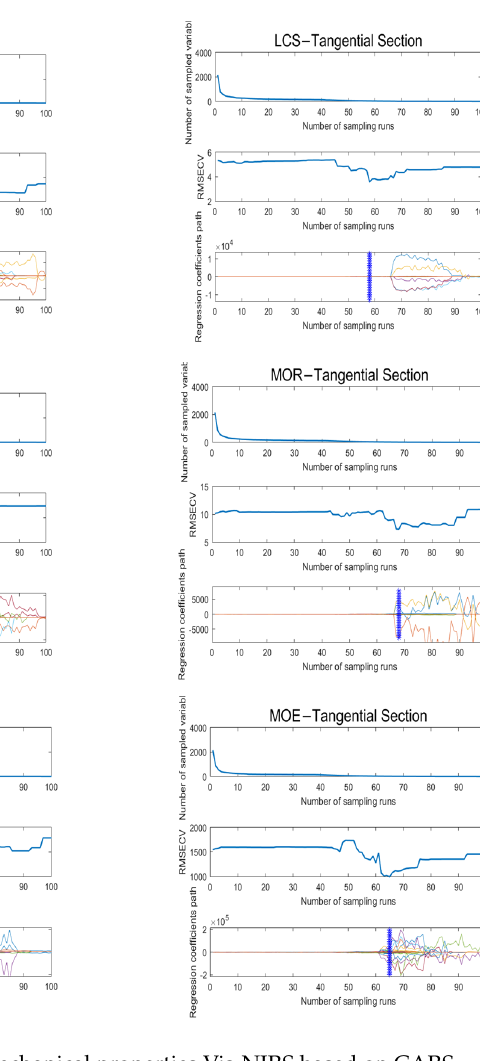
SiPLS was used in combination with UVE, SPA and CARS to screen wavelength